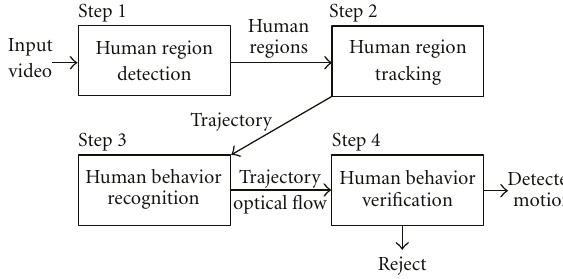
Figure 5: Flow for recognizing specific human behaviors.